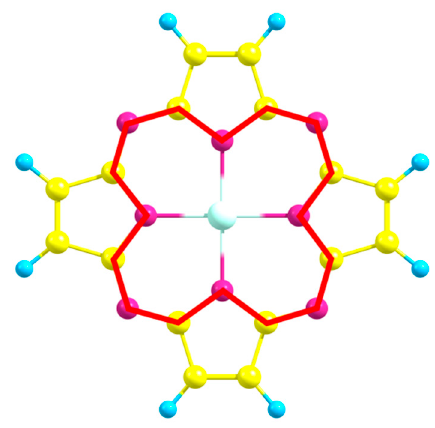
Figure 4. Internal macrocycle Figure 4 . Internal macrocycle perimeter.